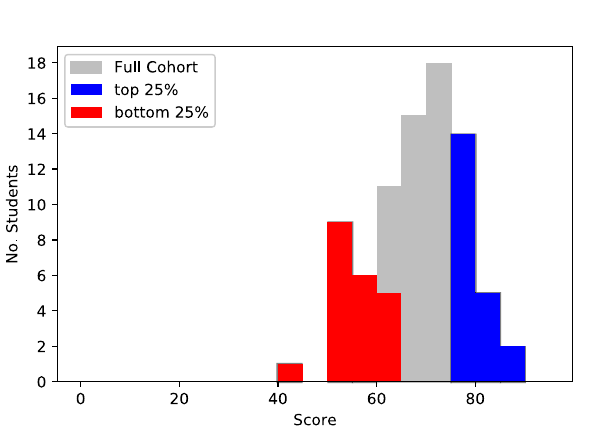
Figure 1. The grade distribution for the entire cohort with the bottom and top 25% groups highlighted in red and blue